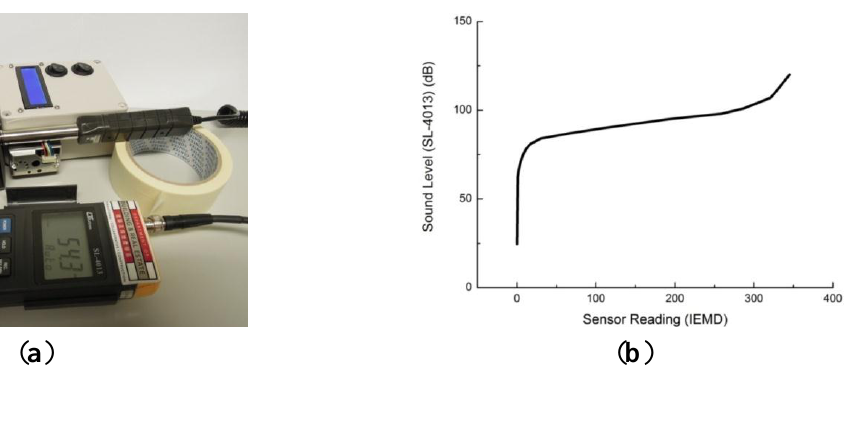
Figure 6. ( a ) Calibration setup for sound level sensor; ( b ) calibration curve for sound level sensor.